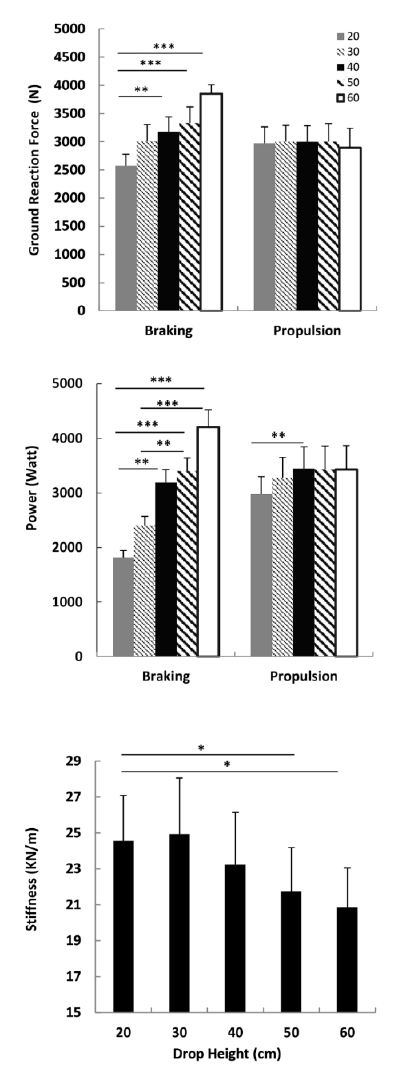
Figure 2. Mean values (SE) of the ground reaction force, power and leg stiffness reported during the drop jumps performed from five drop heights (20, 30, 40, 50 and 60 cm). * Statistical significance (* p < 0.05; ** p < 0.001; *** p <0.0001).